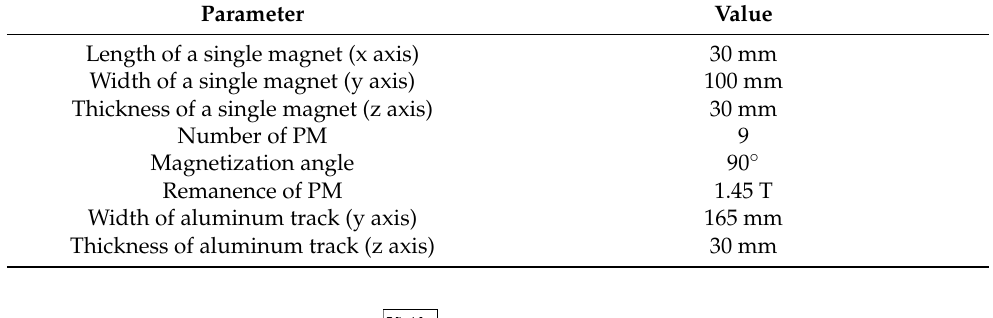
Figure 3. ( a ) Finite element model of the PM EDS system; ( b ) The static magnetic field distribution of the FEM model. Table 1. Parameters of the PM EDS system.